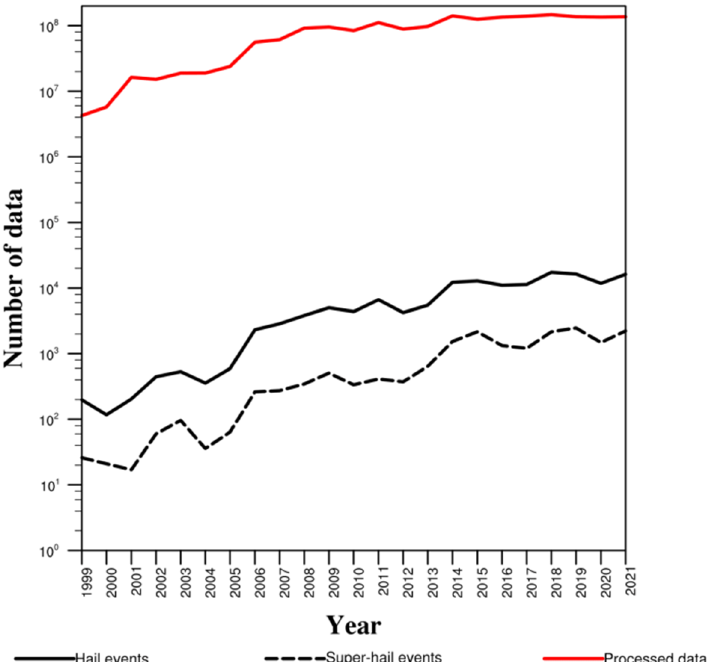
Figure 3. Number of the processed satellite pixels for each year (red line), hail events (solid black line), and super hail events (dashed black line).